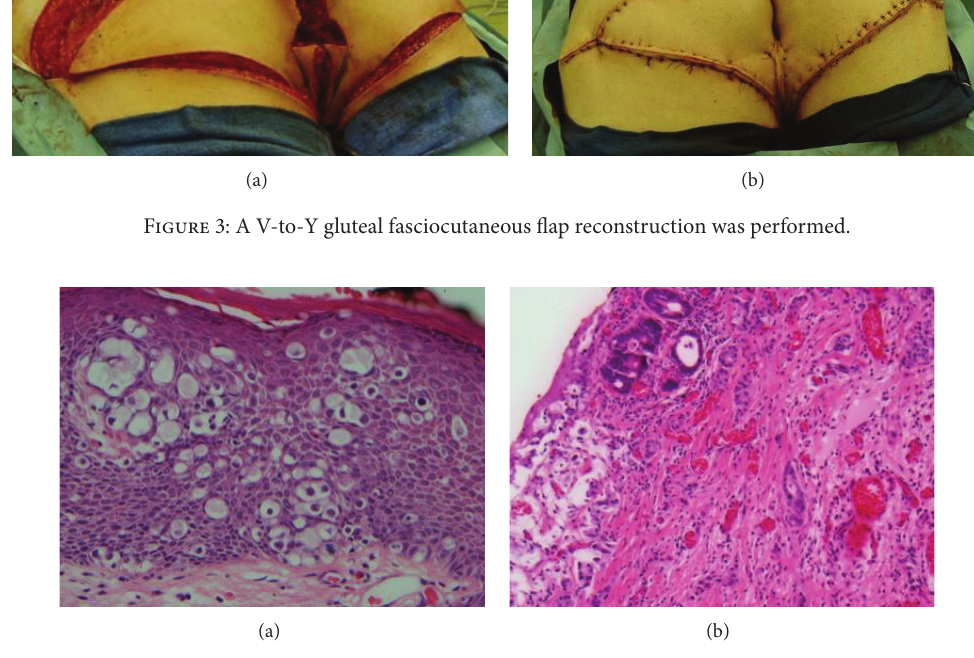
Figure 4: Extramammary Paget’s disease associated with invasive adenocarcinoma of the anal canal, with focal mucinous features seen here.